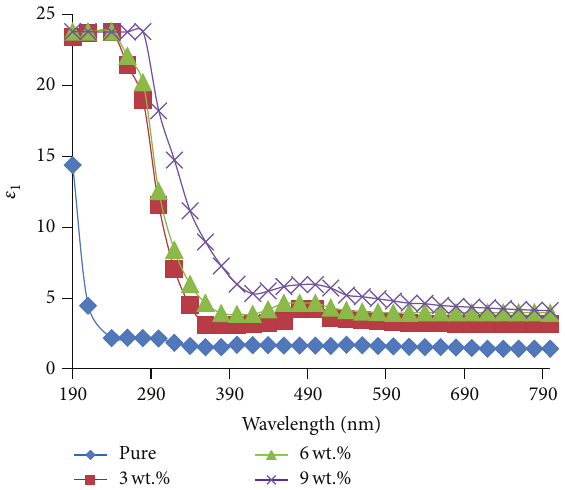
PVAc/6, and PVAc/9 wt.% of [Co(NH 3 ) 5 Cl]Cl 2 composites versus wavelength.